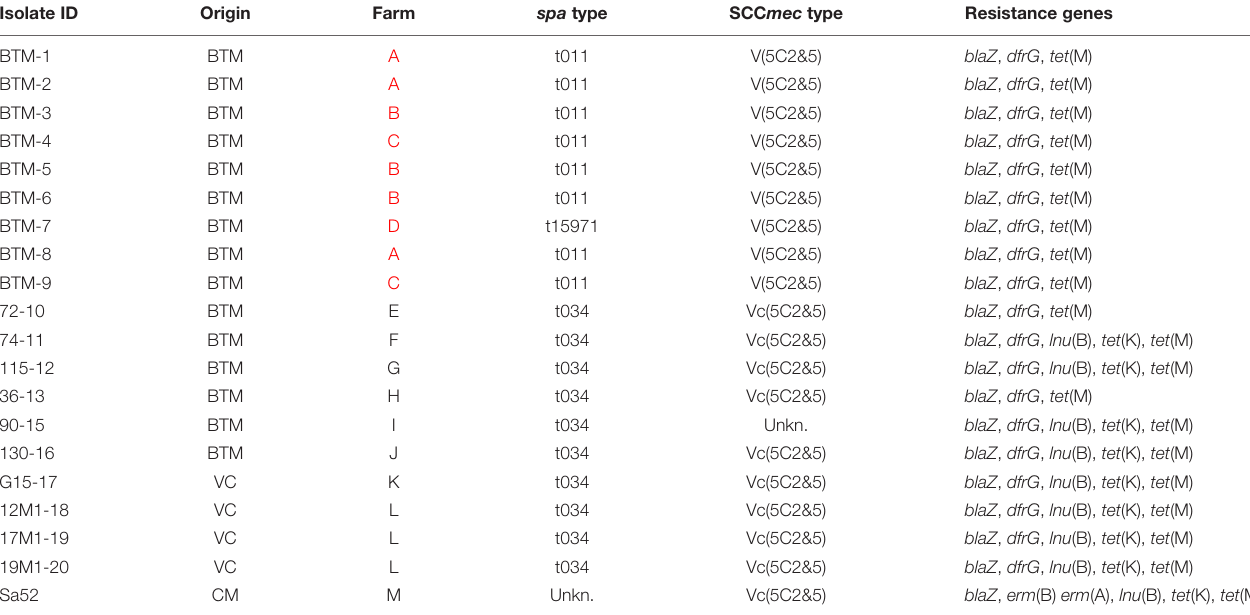
TABLE 1 | Presence of spa types, SCC mec types, and resistance genes among MRSA isolates. Isolate ID Origin